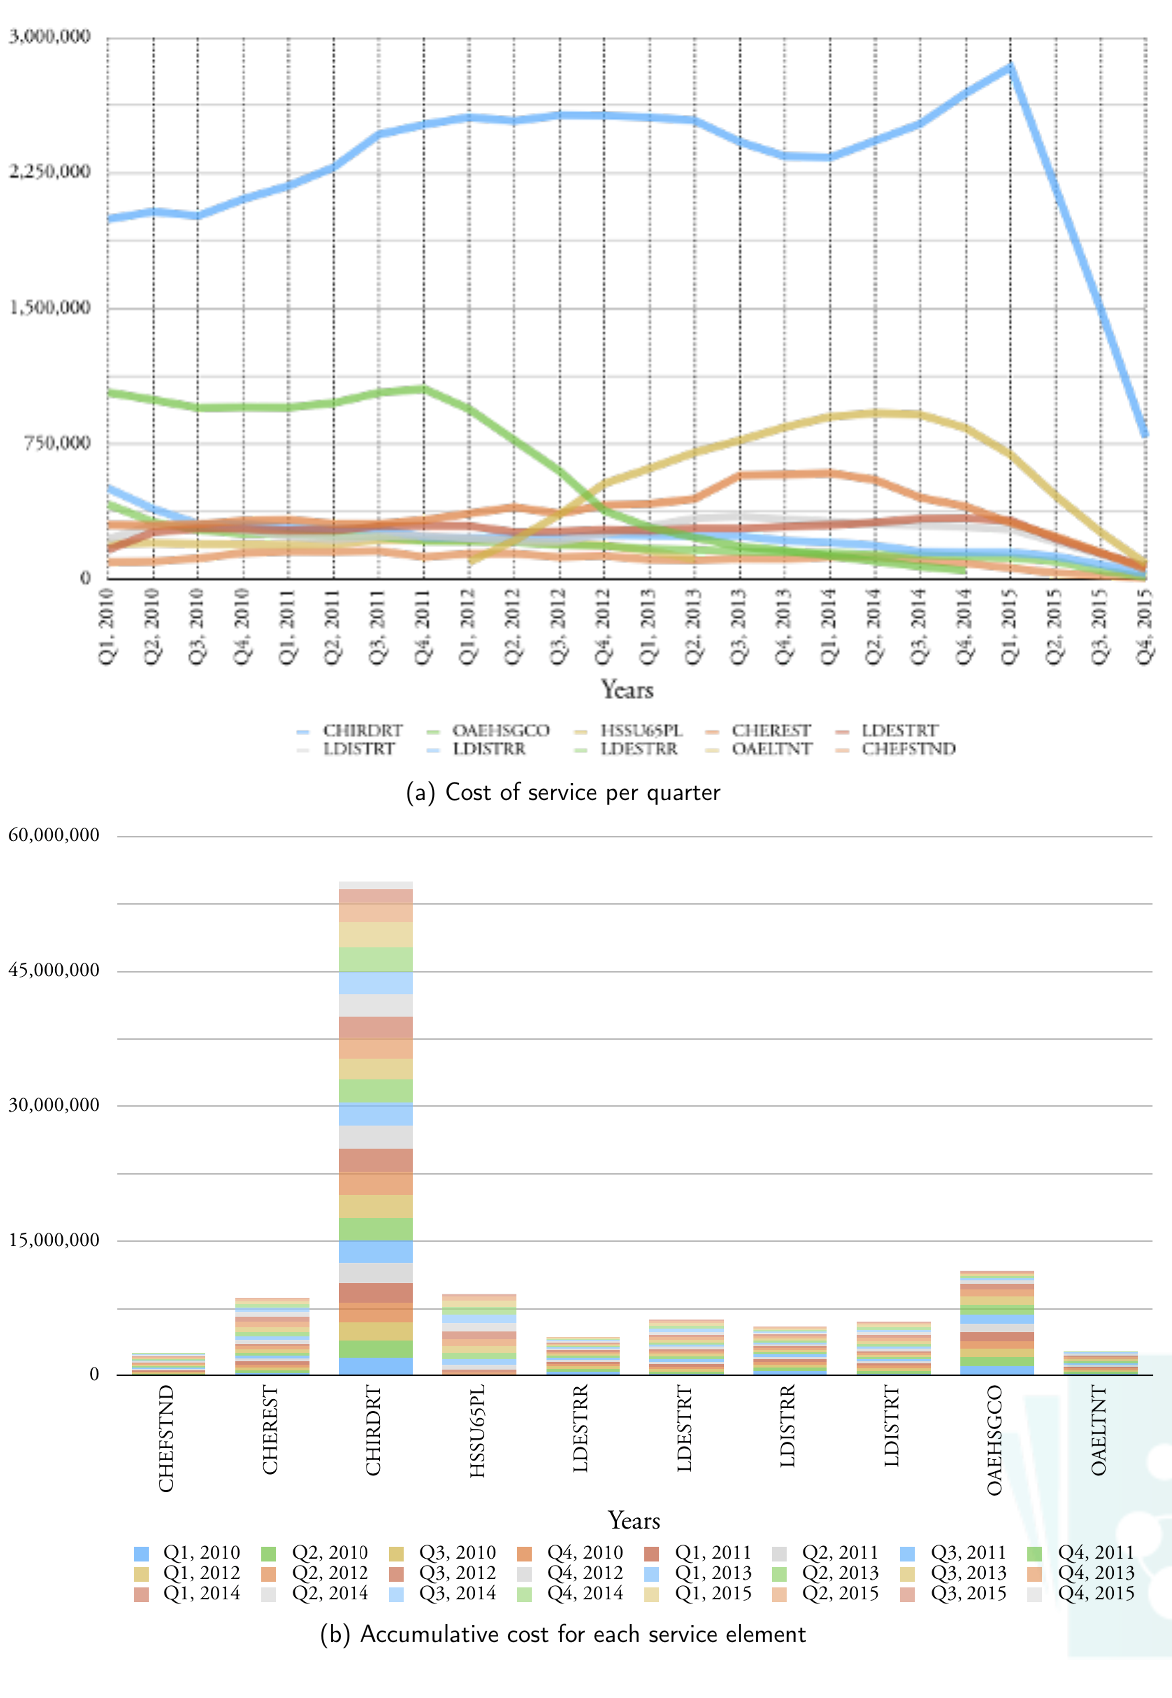
Figure 3: Top ten service elements in terms of cost, for all age categories for the period